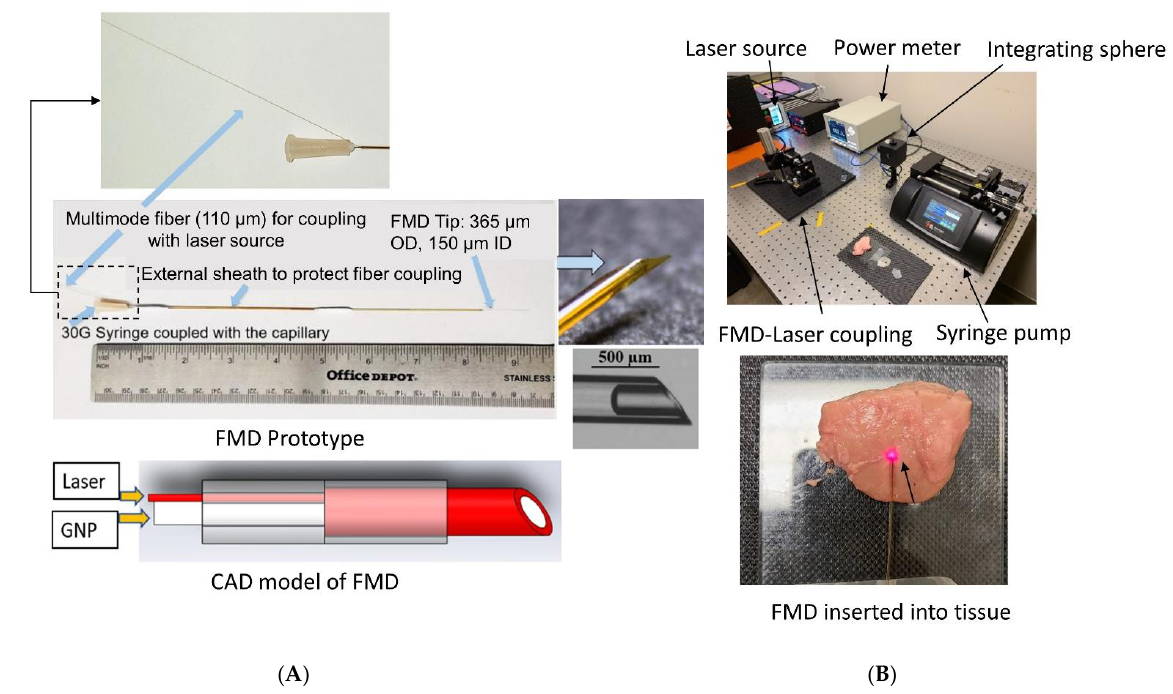
Figure 3. ( A ) Fiberoptic microneedle device (FMD) (Reproduced with permission from [32], Elsevier, 2020 and ( B ) the experimental setup for tissue photothermal heating with FMD at 808 and 1064 nm wavelengths.